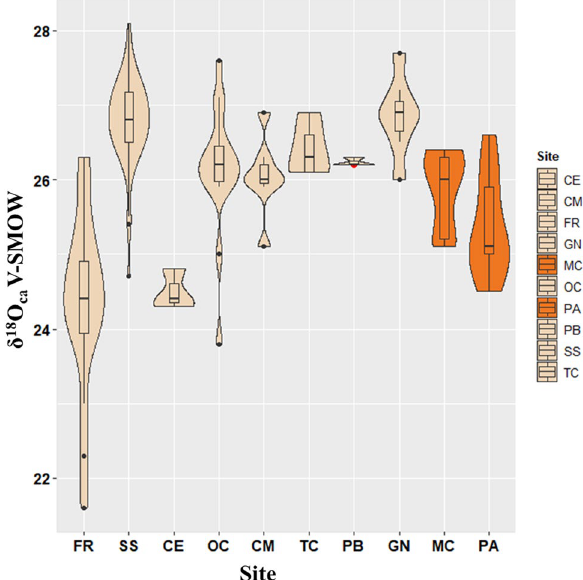
Figure 2. Violin plots for the oxygen isotope values (δ 18 O ca ) of the Copper Age (dark-ivory) and Neolithic (orange) populations. The Copper Age and Neolithic sites are arranged from left to right according to decreasing latitude. The top and bottom limits of the embedded boxes indicate the third and the first quartiles, while the middle lines are the Medians. The top and bottom whiskers cover the statistical range for the population, and single dots represent individual outliers. SS = Buca di Spaccasasso; FR = Fontenoce di Recanati; CM = Casetta Mistici, OC = Osteria del Curato-Via Cinquefrondi; TC = Torre della Chiesaccia, PB = Pantano Borghese; GN = Grotta Nisco; CE = Celano Pratovecchio; MC = Mora Cavorso; PA =